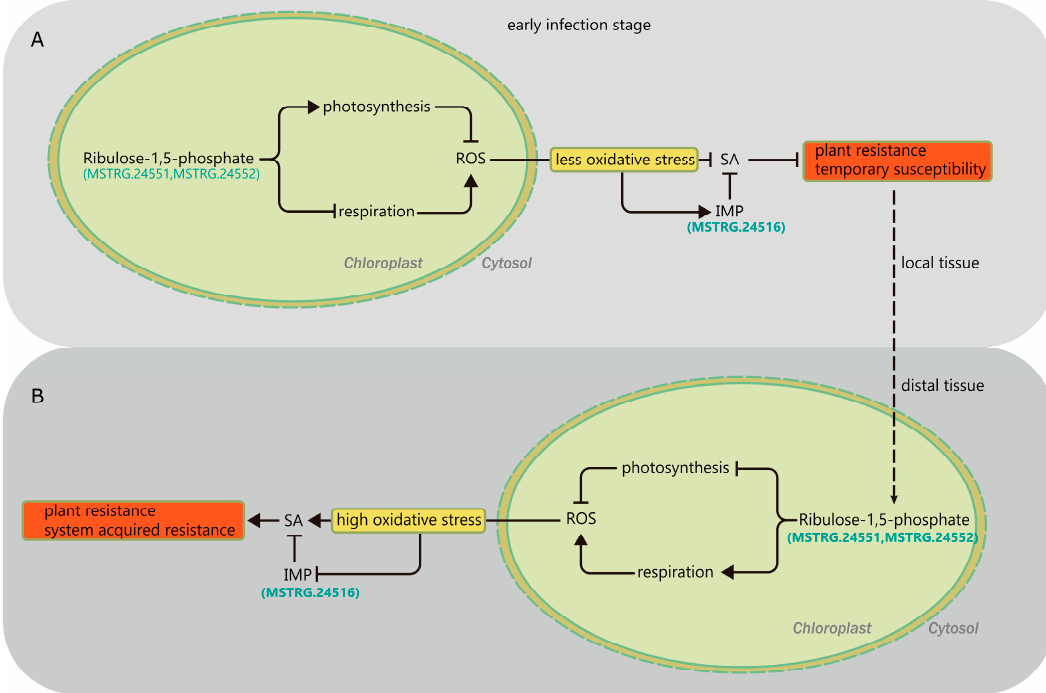
Figure 8. A proposed working model of the roles of MSTRG.24516, MSTRG.24551, and MSTRG.24552 in the regulation of FHB resistance in wheat line L693. ( A ) In the early infection stage, FHB induces temporary susceptibility locally in a tissue; ( B ) this then leads to system-acquired resistance in distal tissues.